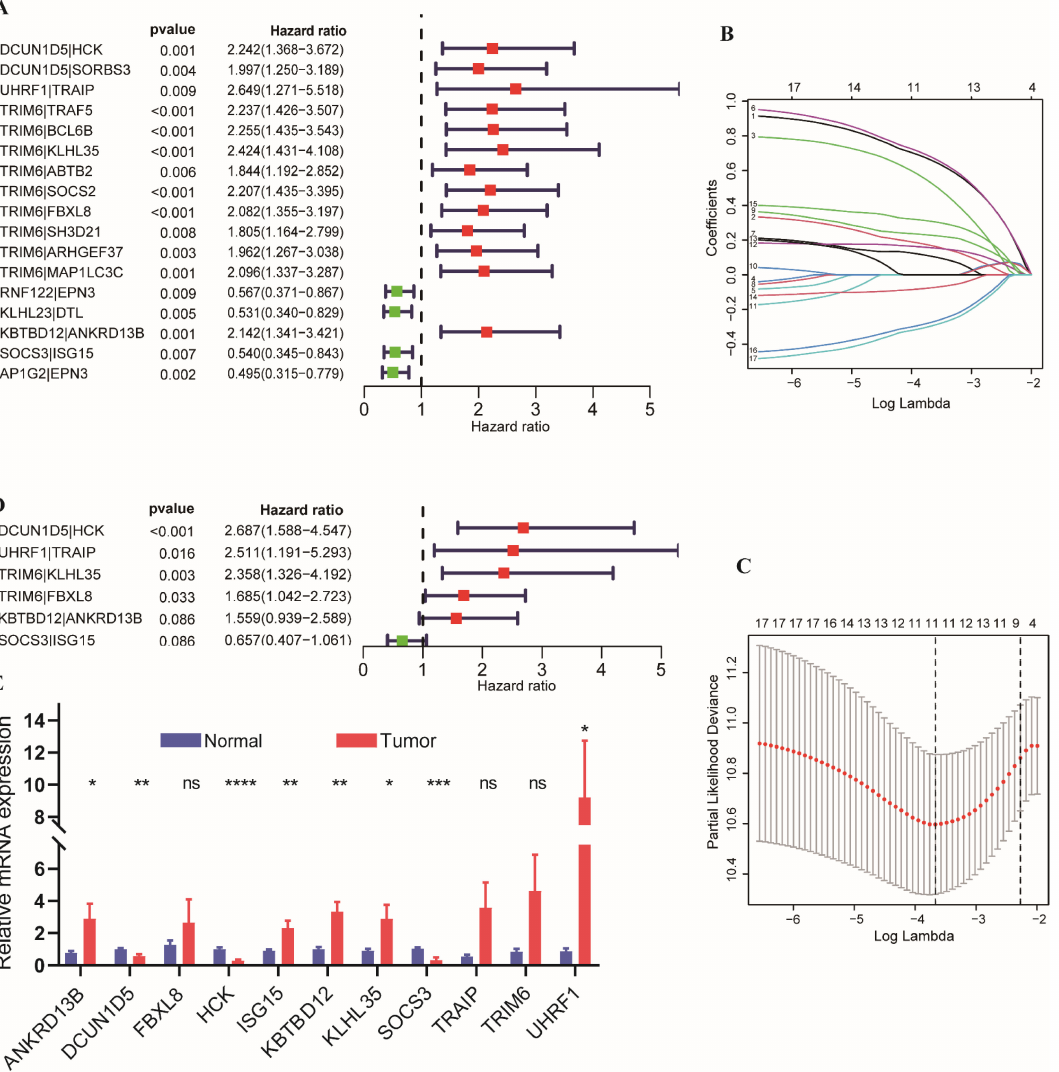
Figure 4. The prognostic signature of patients with LUAD was established based on UbRGPs in the TCGA training set. ( A ) Forest map of the 17 UbRGPs related to OS. ( B ) The distribution of the LASSO coefficient. ( C ) Selection of the 11 optimal parameters when Log Lambda = − 3.7 in the LASSO model. ( D ) The forest map showed the six UbRGPs, which were used to establish the prognostic signature. ( E ) The relative mRNA expression levels of 11 UbRG genes in LUAD samples from Wuhan Union Hospital by qRT-PCR. Data are presented as the mean ± standard error of the mean (SEM). (* p < 0.05; ** p < 0.01; *** p < 0.001; **** p < 0.0001; ns, p ≥